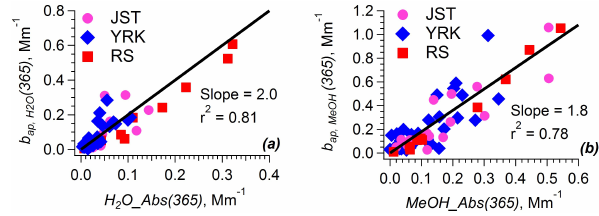
Fig. 5. Comparison of Mie-predicted absorption to solution absorp- tion for (a) water extracts and (b) methanol extracts at 365nm. Data are all fine stages from the 6 MOUDI samples collected. An orthog- onal distance regression (ODR) fit was applied. The correlation did not change with either aerosol size or sampling sites suggesting a robust relationship. The slope and r 2 given is for combined data.